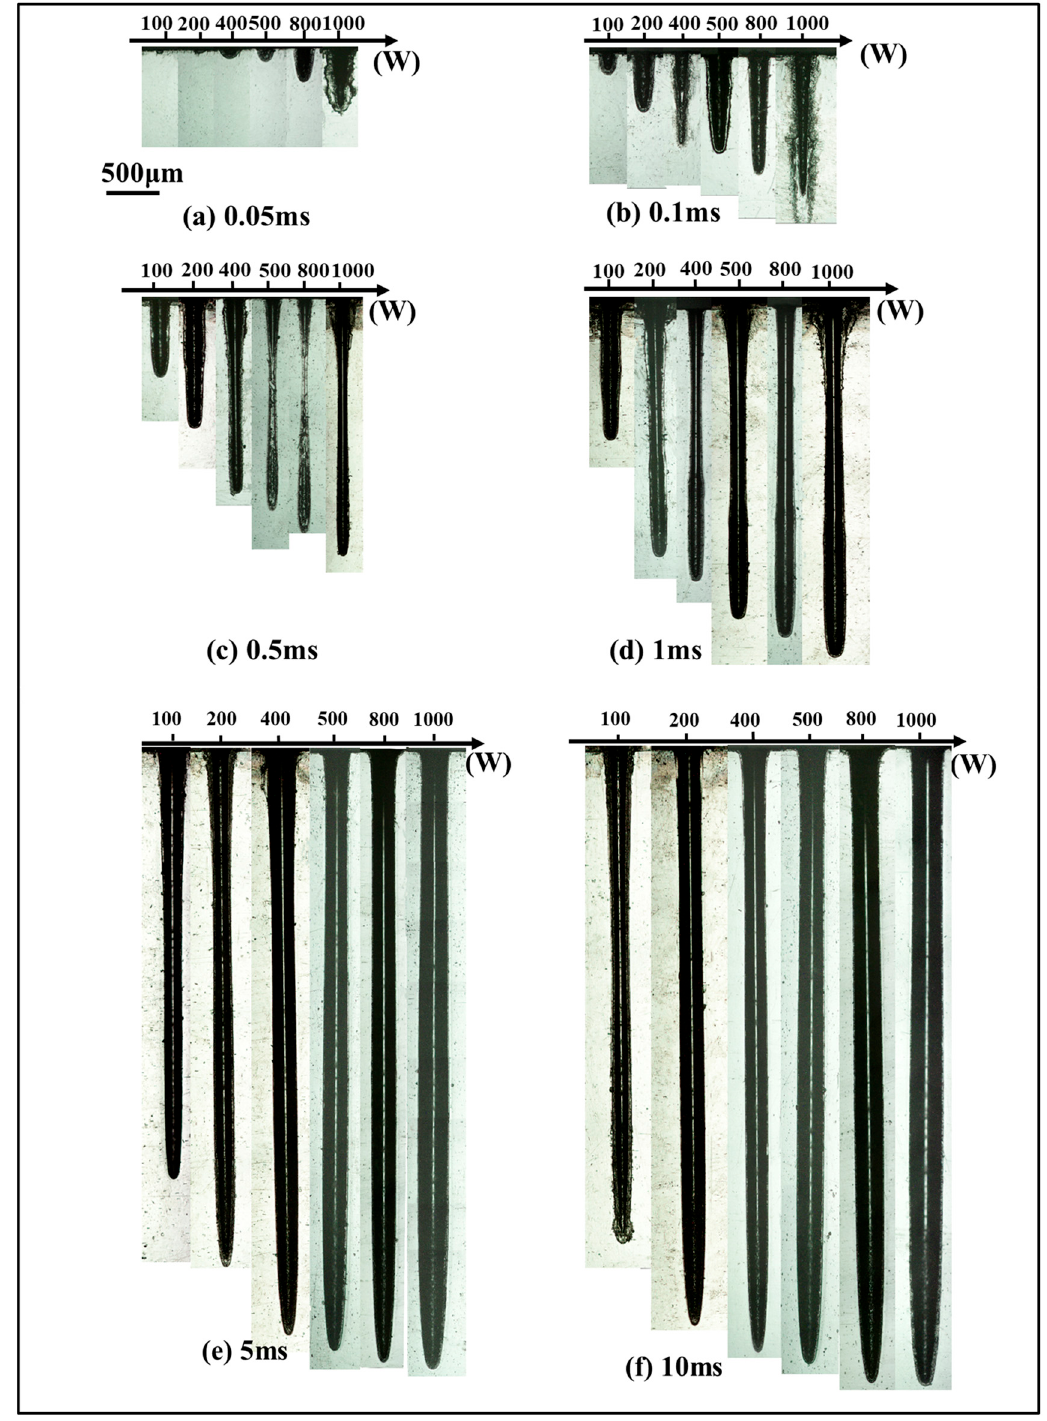
Figure 3. Sectional morphology of the hole under different peak powers with pulse widths of ( a )